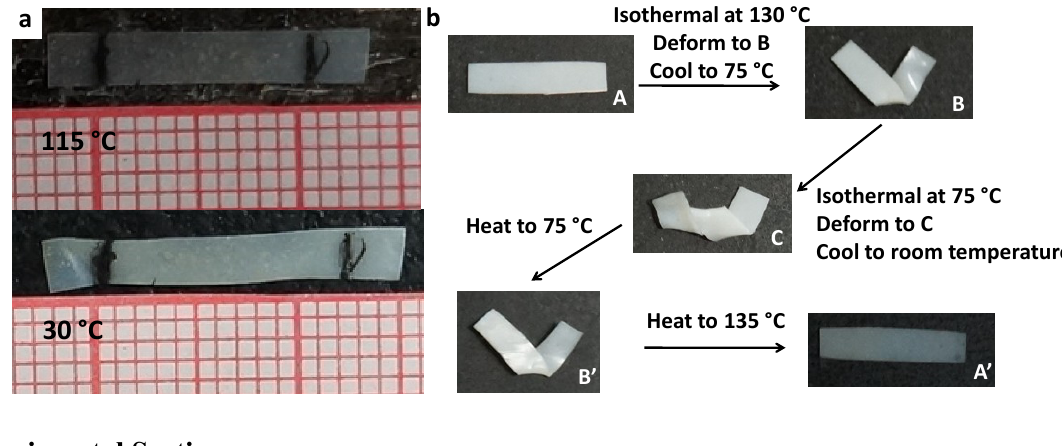
Figure 6. ( a ) The change of natural length of a free-standing monodomain xLCNs/SiO composites (xLCN/SNP) (5 wt%) between the liquid-crystal phase (30 °C) and the isotropic phase (115 °C); ( b ) Triple shape memory of a polydomain xLCNs/SiO (xLCN/SNP) (5 wt%)